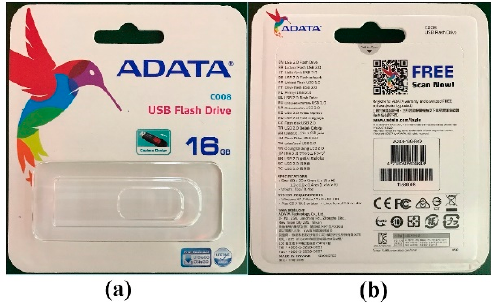
Figure 2. Both front and back sides of the object.